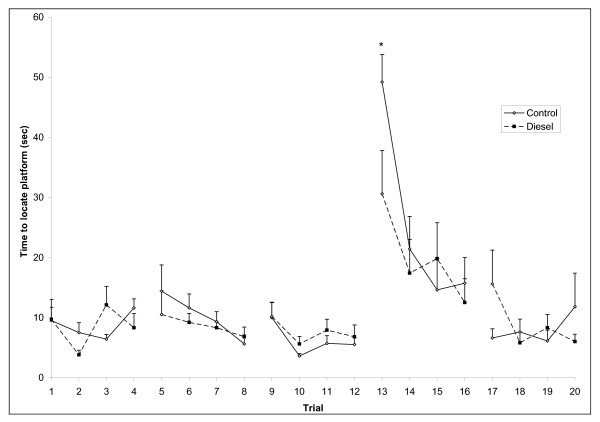
Memory in the Morris water maze for female offspring. Data represent mean+SEM. Latency to locate the hidden platform is presented for memory (three days, i.e. trial 1–12; reversal, trial 13–16, and new, trial 17–20). DEP exposed offspring located the platform faster than controls on the first trial of reversal learning. n = 10. *p < 0.05.